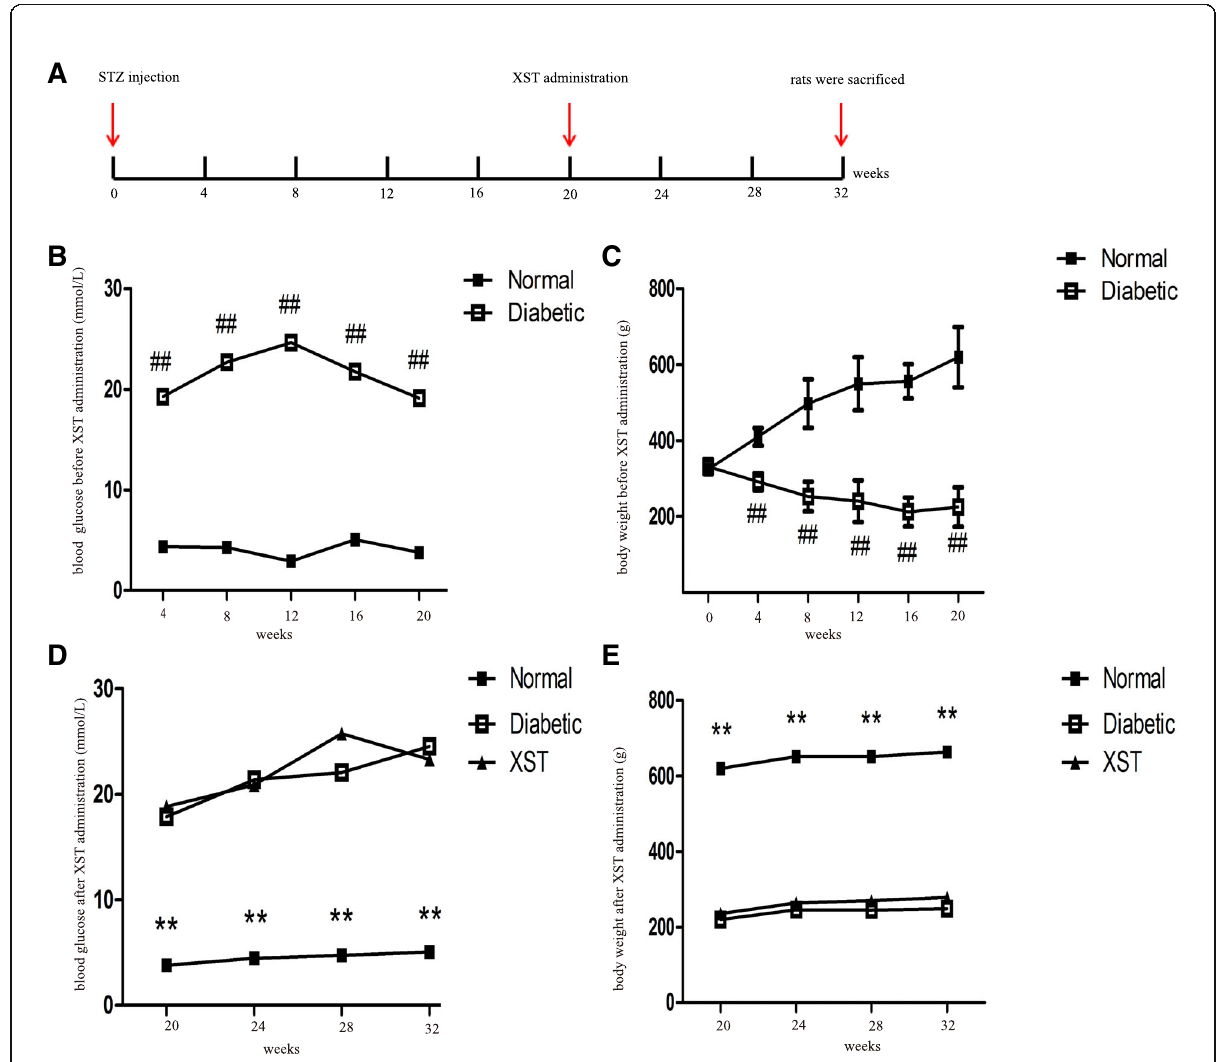
Fig. 1 The blood glucose and body weight of rats. Diabetic rats were induced by streptozocin. The normal control rats received citrate buffer. The blood glucose and body weight were measured every 4 weeks. 20 weeks later, the rats whose blood glucose was higher than 16.7 mmol/L were divided into diabetic group and XST group. Then XST administration started and continued for 12 weeks. a Time schedule. b – c The blood glucose and body weight before XST administration. ##: P < 0.01, compared to Normal. d – e The blood glucose and body weight after XST administration. There was no significant difference between diabetic group and XST group. **: P < 0.01, compared to